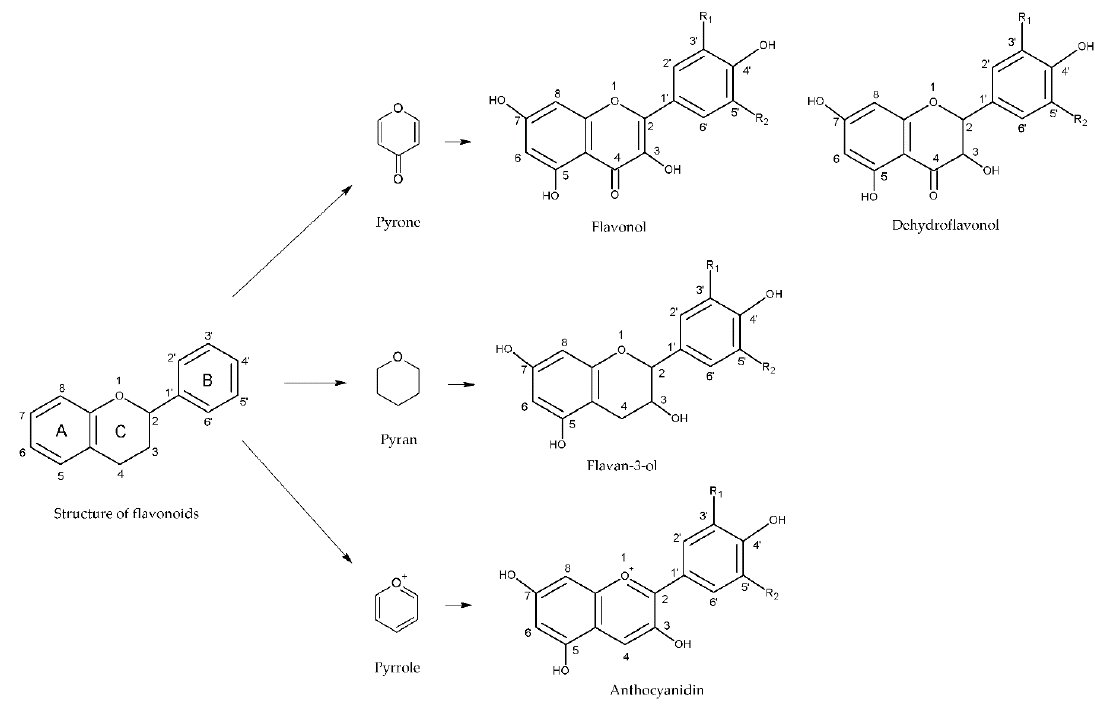
Figure 3. General flavonoid structure. Adapted from References [20,30]. R 1 , R 2 = H, OH, OCH 3 .